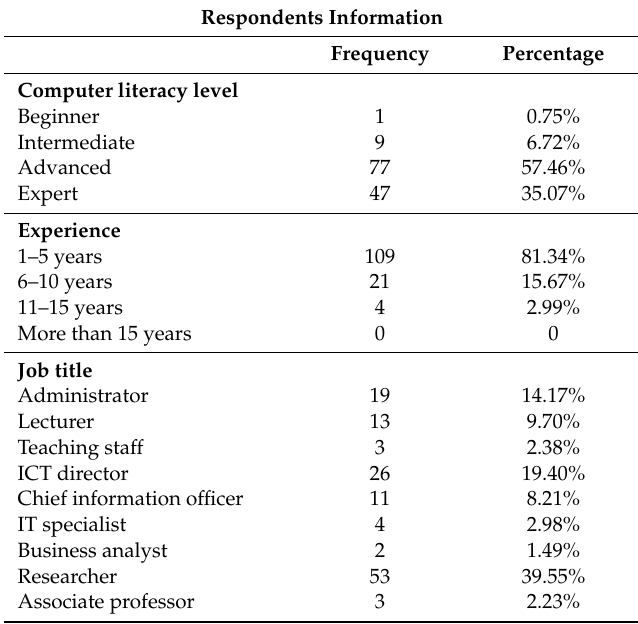
Table 4. Characteristics of the